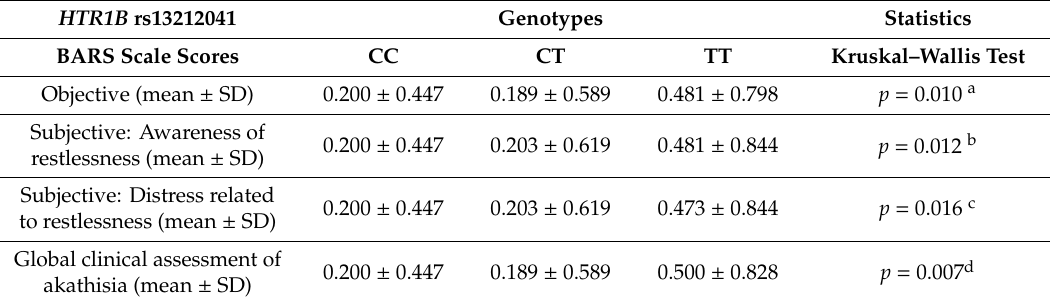
Figure 1. BARS scores of haloperidol-treated schizophrenia patients subdivided according to their HTR1B rs13212041 polymorphism status: ( A ) carriers of the homozygous CC genotype (0.800 ± 1.789) vs. carriers of the T allele (1.517 ± 2.996); ( B ) carriers of the homozygous TT genotype (1.931 ± 3.228) vs. carriers of the C allele (0.785 ± 2.341). * p = 0.002; Mann–Whitney test, TT vs. C carriers. Table 5. Scores of individual BARS items in haloperidol-treated schizophrenia patients carrying different genotypes of the HTR1B rs13212041 polymorphism.